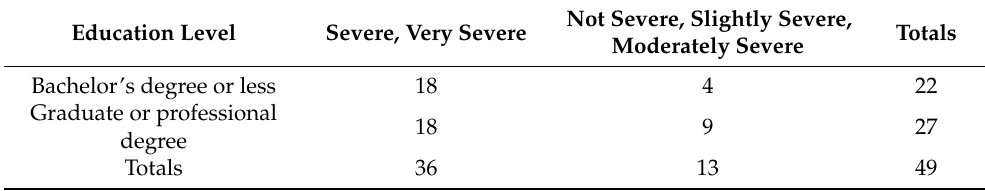
Table 2. Education level achieved by survey respondents and their perceptions on